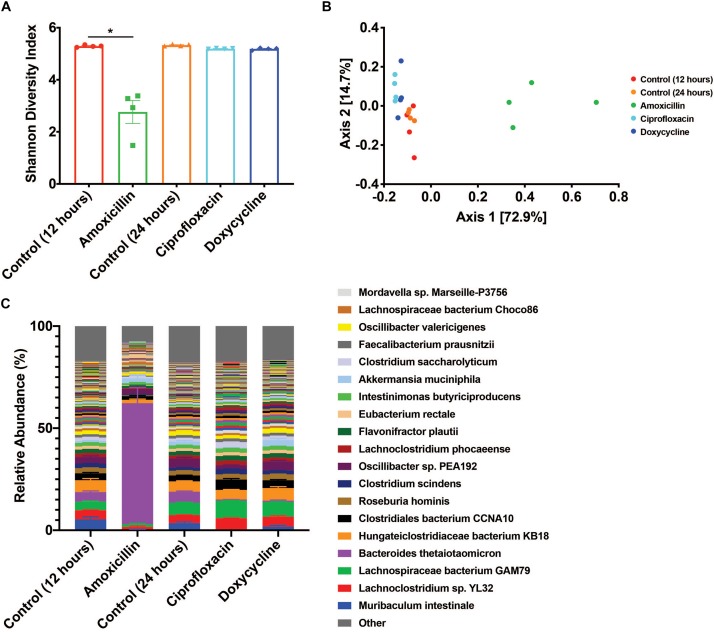
Antibiotic treatment has variable impacts on the diversity and taxonomic structure of the microbiome. (A) Shannon diversity index displayed as mean ± SEM (*p < 0.05 Mann-Whitney U test, n = 4). (B) PCoA based on Bray-Curtis beta diversity. (C) Relative abundance of bacterial species displayed as mean ± SEM (n = 4, top 250 most abundant species colored, full relative abundance table available in Supplementary Table S2).